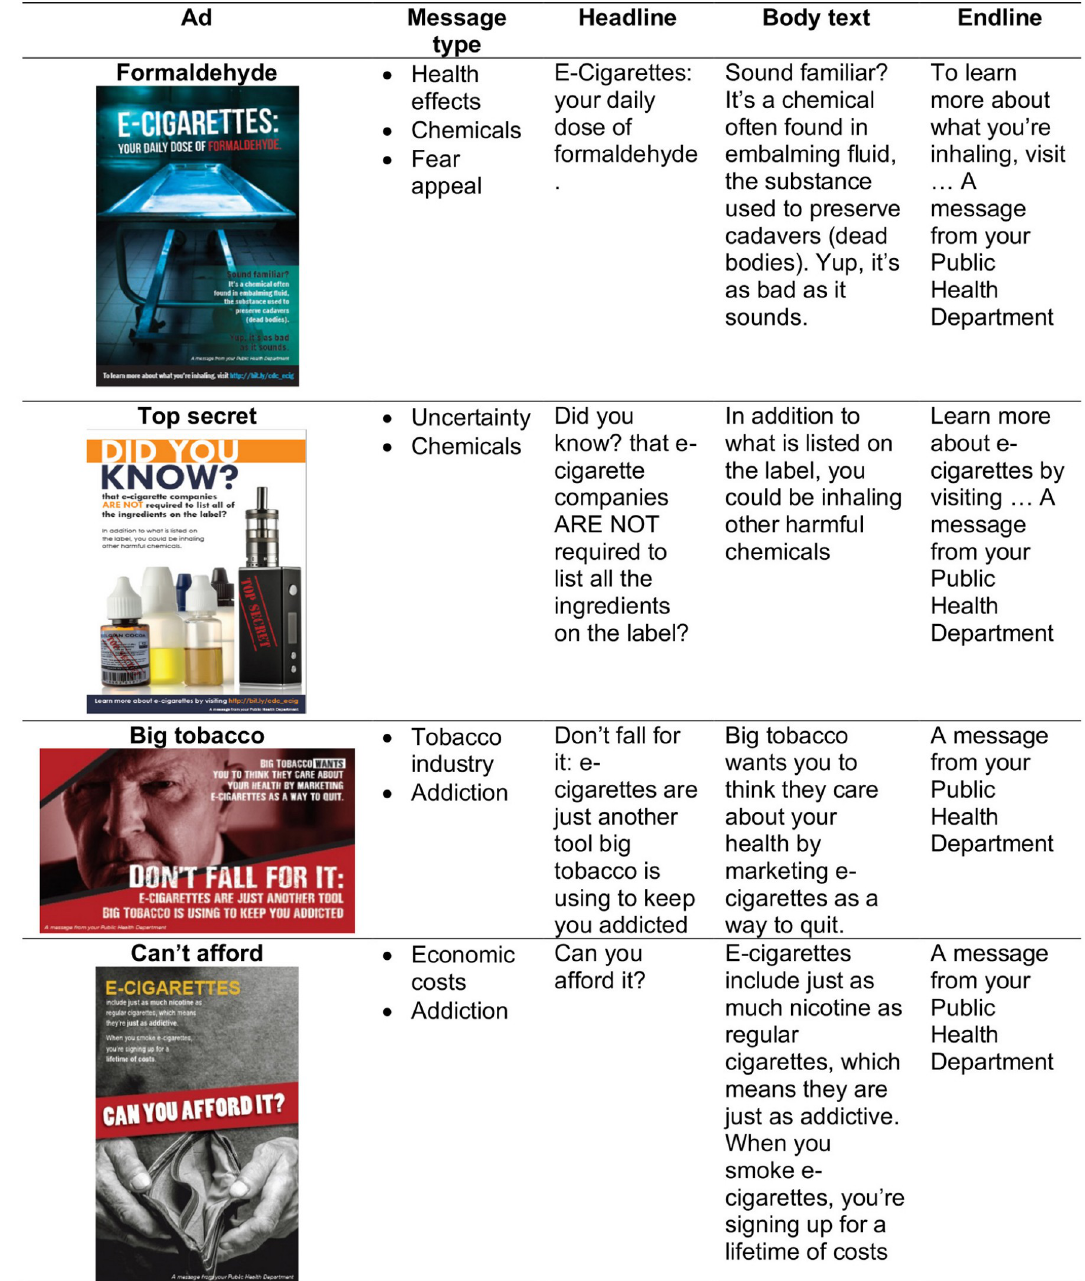
Fig 1. Description of e-cigarette messages used in the